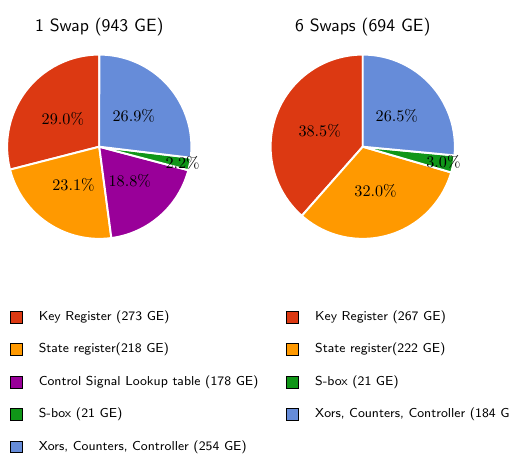
Figure 13: Breakdown of the area requirements of the individual components of PRESENT in the 1 and 2 swap